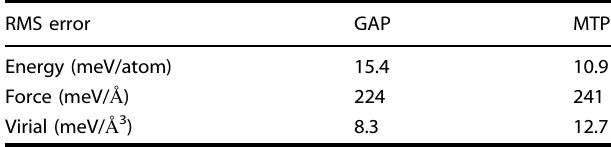
Table 5. Model validation for GAP and MTP models using the liquid